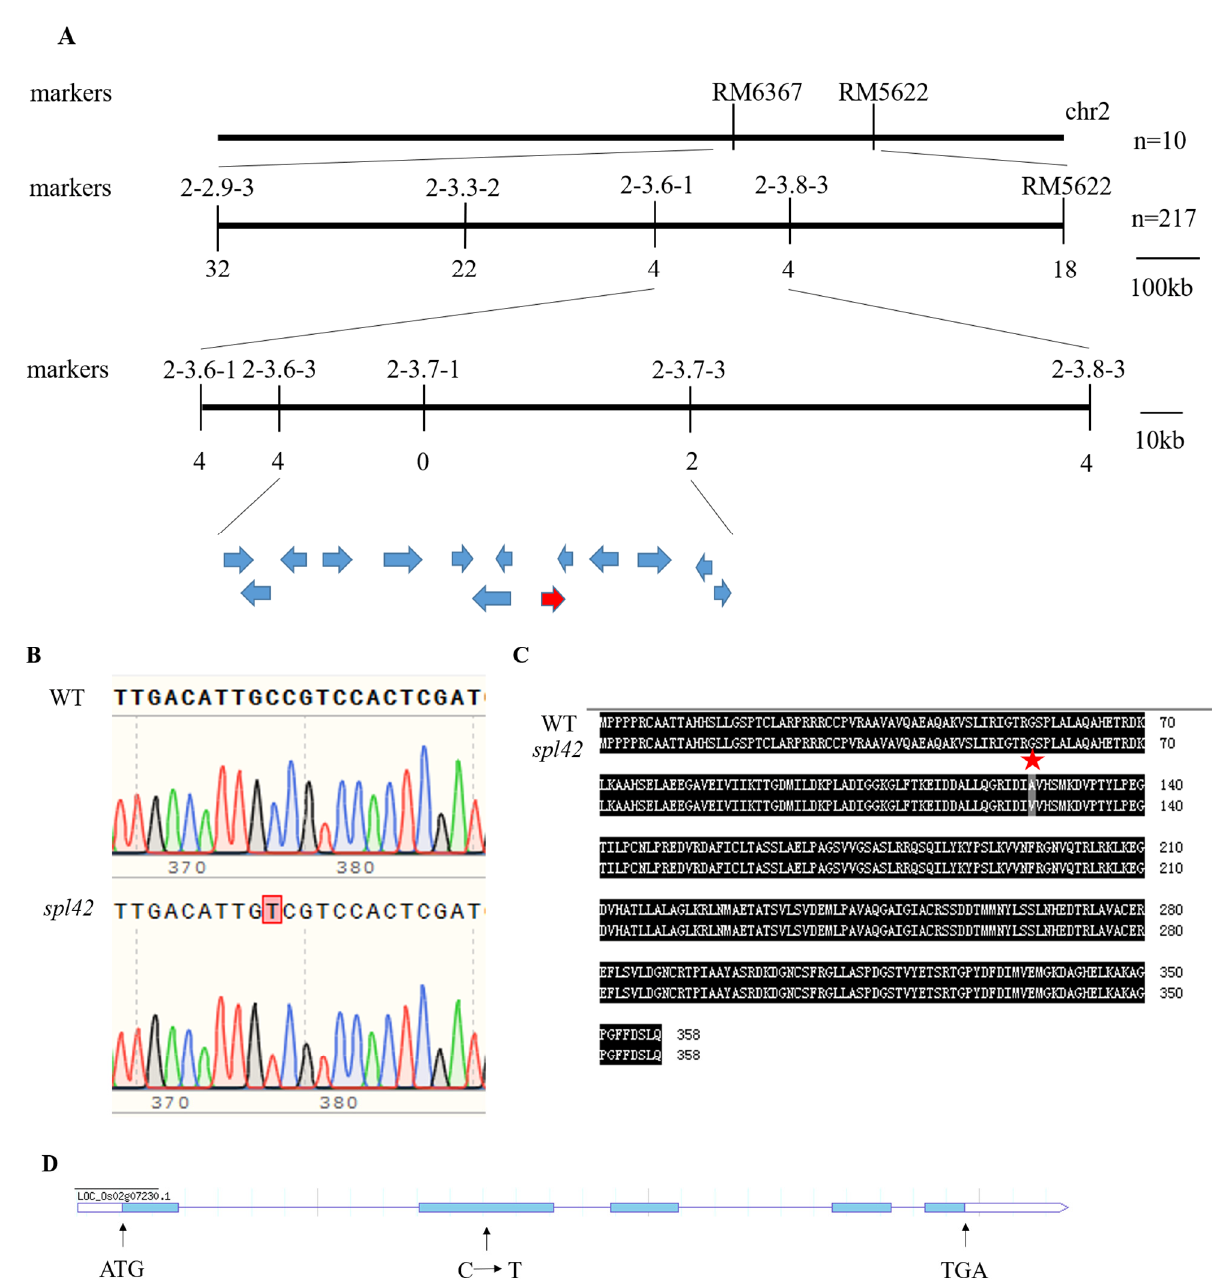
Figure 5. Map-based cloning of the SPL42 gene. ( A ) The SPL42 locus was delimited to a 123 kb genomic region between markers 2-3.6-3 and 2-3.7-3 on the short arm of chromosome 2. Fourteen open reading frames (indicating by arrow) were predicted in the region. Numbers below the chromosome indicate the numbers of recombinant individuals in gene mapping. ( B ) Sequencing results of the wild type (WT) and the spl42 mutant. The mutated nucleotide was boxed. ( C ) Amino acid sequence alignment of the wild type and spl42 mutant. A star indicates the putative amino acid change between the wild type and spl42 mutant. ( D ) SPL42 gene structure. ATG represent the start codon and TAG is stop codon, and the blue boxes represent exons, while the lines between the blue boxes represent introns. The single base substitution of C-T (arrow) causes amino acid